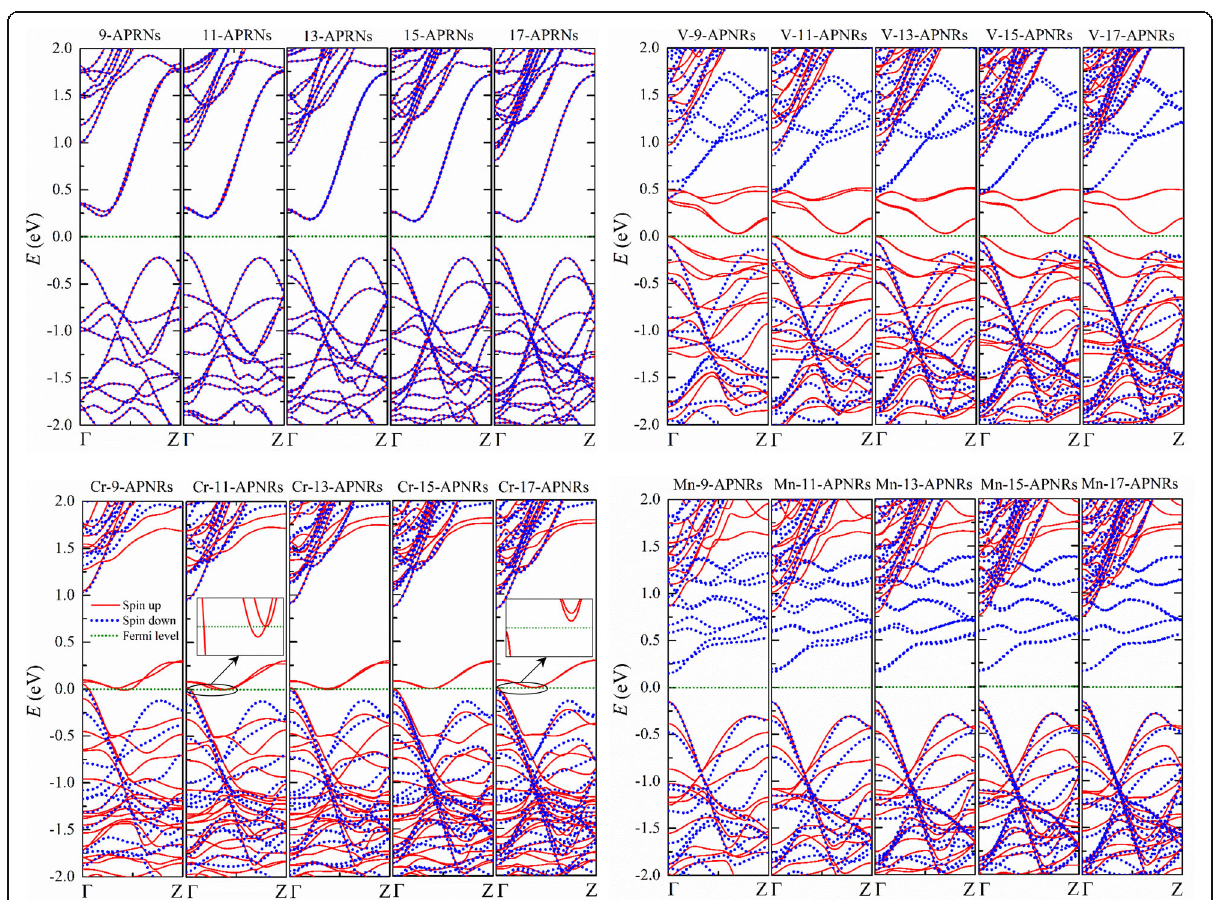
Fig. 4 Band structures of pristine n -APNRs and those edge-modified by V, Cr, and Mn atoms for various n . Zoomed views of Cr- n -APNRs near the Fermi level are shown in the insets for n = 11 and 17